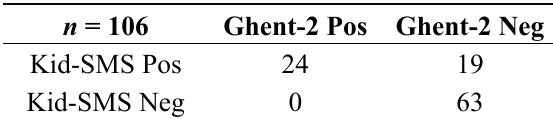
Table 4. Fourfold table of risk stratification with Kid-SMS and diagnosis with Ghent-2 at follow-up visit, p < 0.05. (Ghent-2 Pos, revised Ghent Criteria positive; Ghent-2 Neg, revised Ghent Criteria negative; Kid-SMS Pos, Kid-Short Marfan Score positive, Kid-SMS Neg, Kid-Short Marfan Score